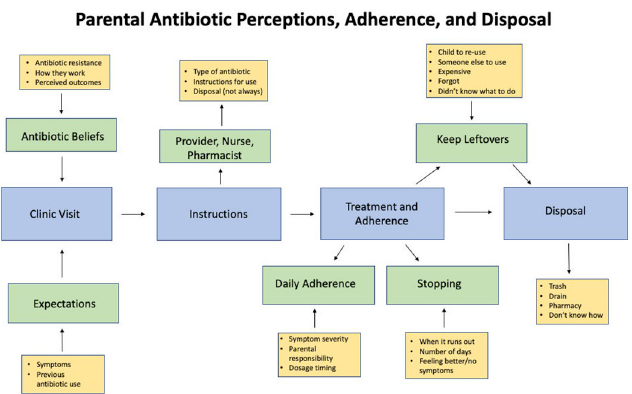
Fig 1. Flowchart of parental perceptions, adherence, and disposal practices of antibiotics. The blue boxes depict the main stages of parents receiving an antibiotic for their child. The green and yellow boxes depict factors that influence the disposition of antibiotics at each stage. The arrows pointing inward towards a box signify factors that weigh into beliefs or actions surrounding antibiotics. The arrows pointing outward signify future steps or actions impacted by previous